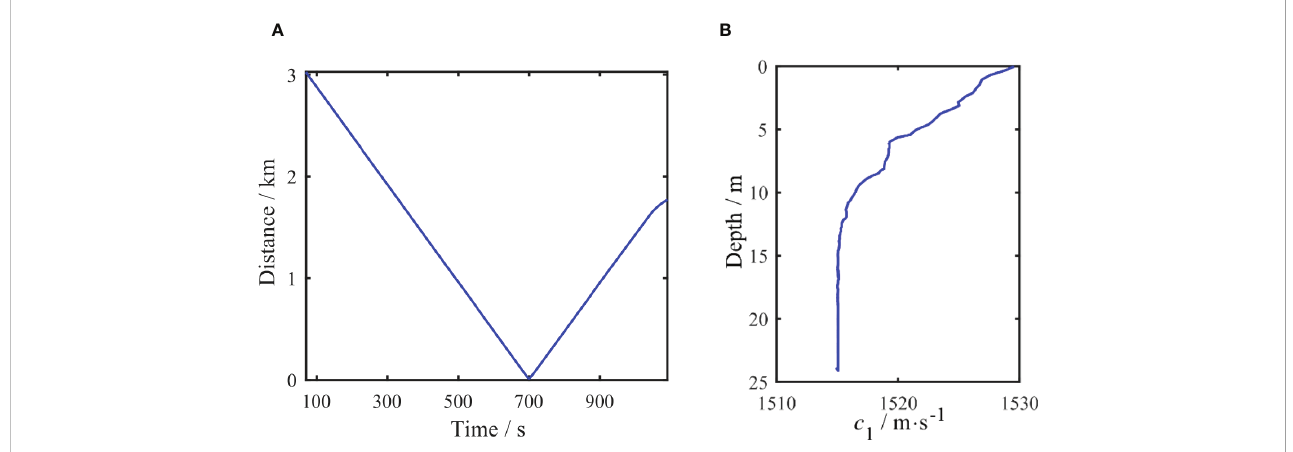
FIGURE 11 The distance between the source ship and the receiving ship with time during the experiment (A) , and the sound speed pro fi le of the experiment sea area (B)